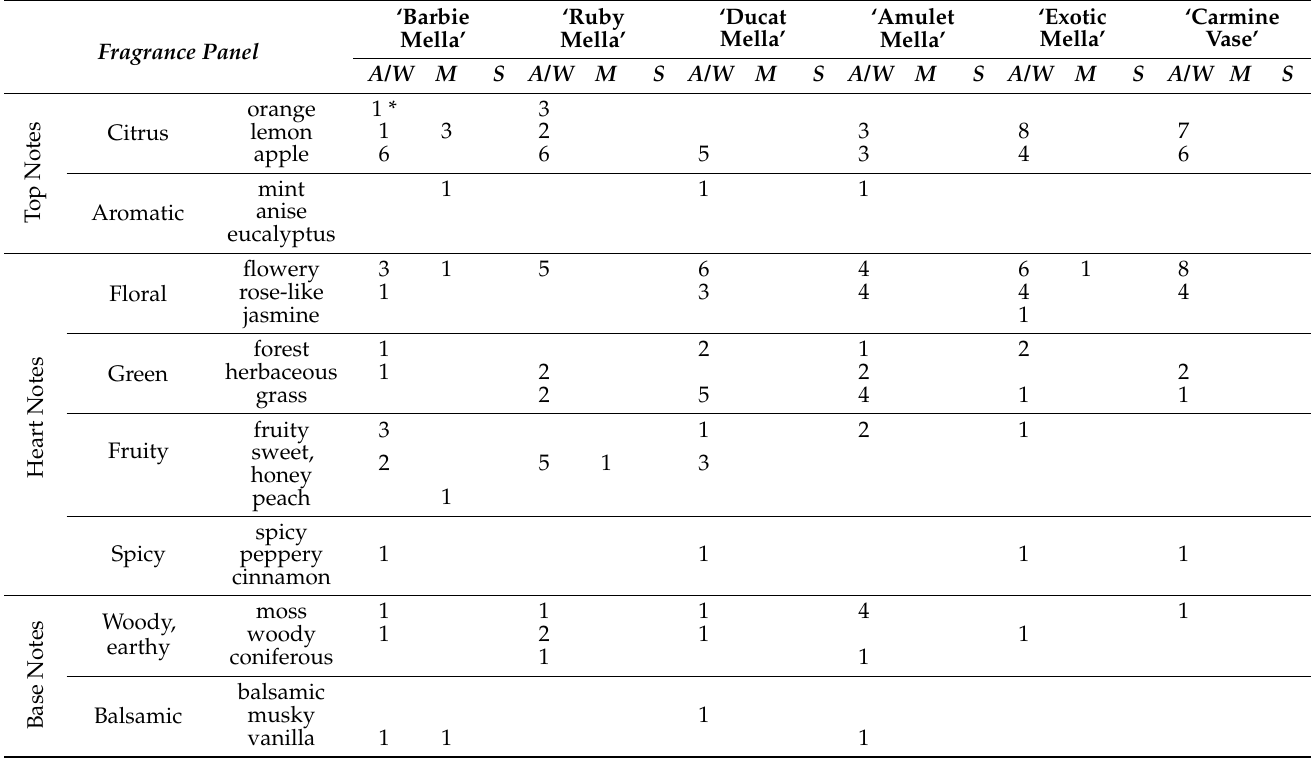
Table 3. Human perception of floral scent in the investigated ‘Mella’ rose